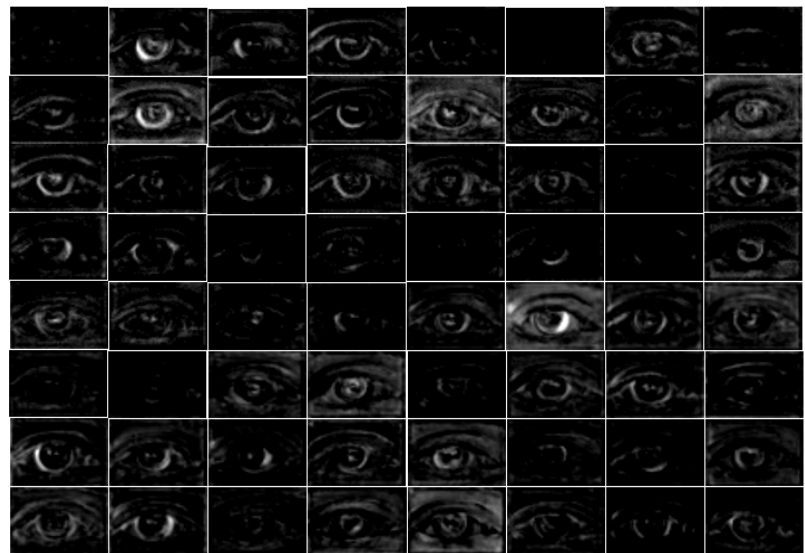
Figure 20. IrisDenseNet last 64 channel (the 449th to 512th channels) features for the 4 th dense block before the 4th max-pooling (Pool-4 of Table 2).